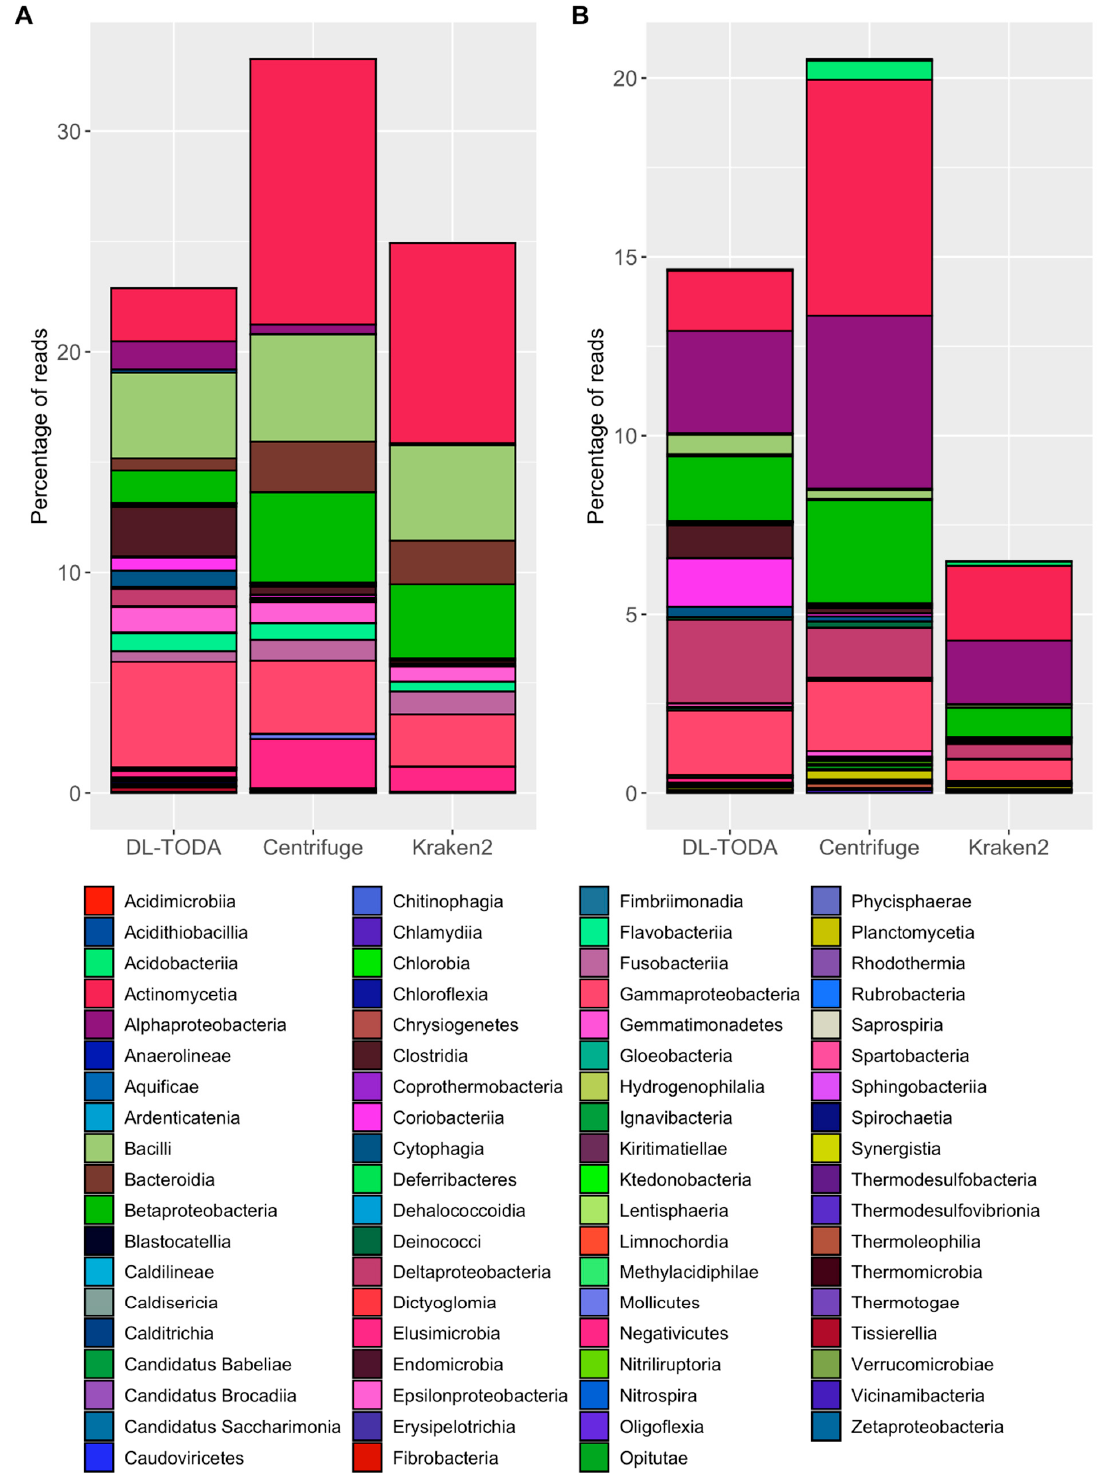
Figure 7. Taxonomic distribution of metagenomic reads at the class rank based on predictions made by DL-TODA, Centrifuge and Kraken2 in the human oral ( A ) and soil ( B ) metagenomes. The Y-axis indicates the percentage of reads over the entire metagenome. The two panels are color coded with the same color pallet so that the same color indicates identical taxa across the different stacked